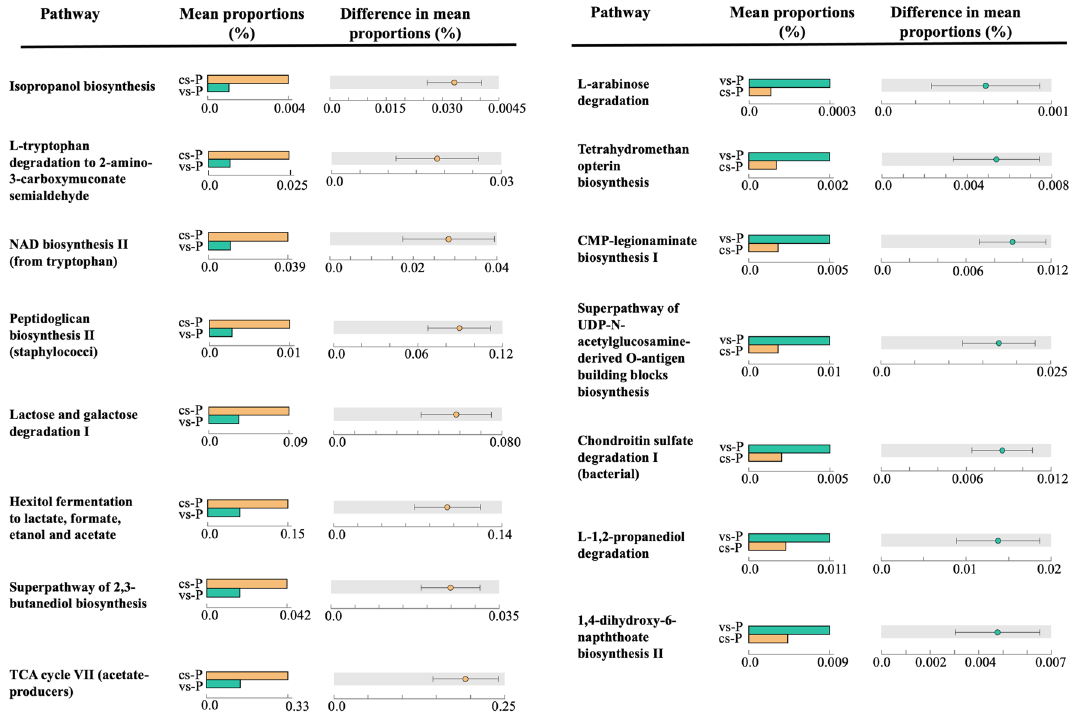
Figure 7. Predicted KEGG functional pathways using PICRUSt analysis. Most statistically significant differential pathways between the nasal microbiota of piglets from vaccinated (vs-P) and control sows (cs-P) are shown (Kruskal–Wallis post-hoc test with Bonferroni correction). Pathways more relatively abundant in the cs-P samples are shown on the left, and those more relatively abundant in the vs-P samples are shown on the